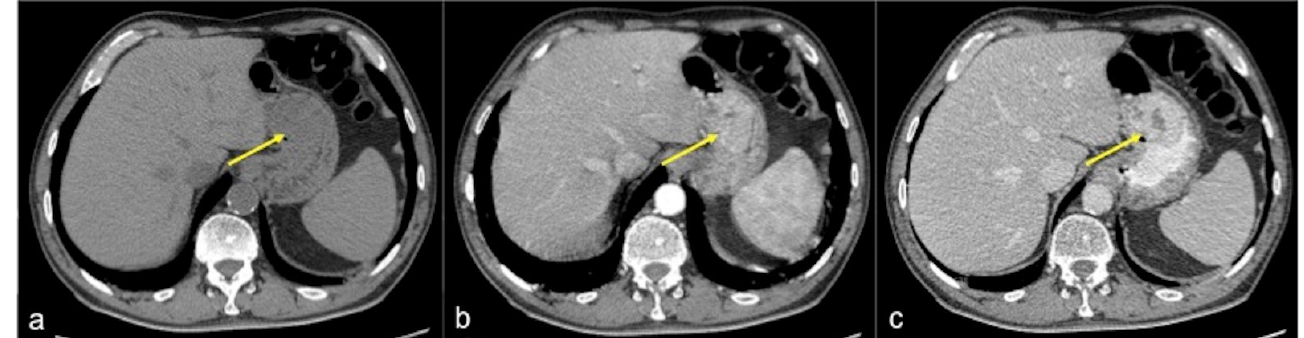
Figure 26. CTA multiphasic study of gastric GIST. In the pre-contrast ( a ), arterial ( b ) and venous ( c ) phases a large vascularised lesion in the gastric body with massive haemorrhagic lumen inundation is visible.